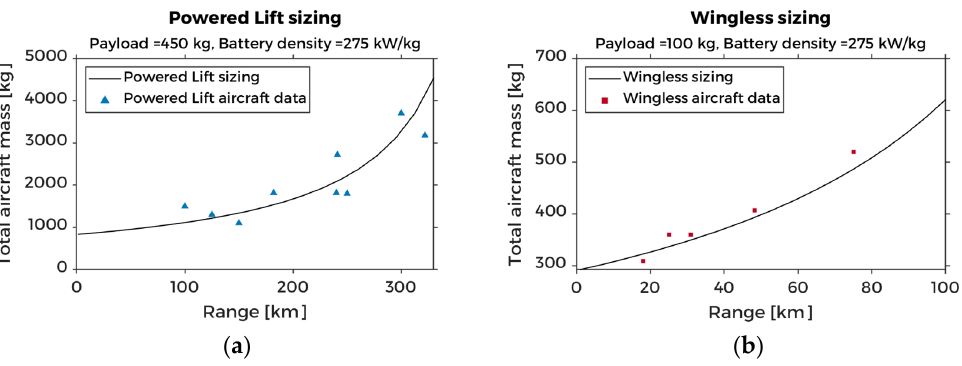
Figure 14. ( a ) Powered lift sizing result compared with powered lift eVTOL aircraft data and ( b ) wingless sizing result compared with wingless eVTOL aircraft data.